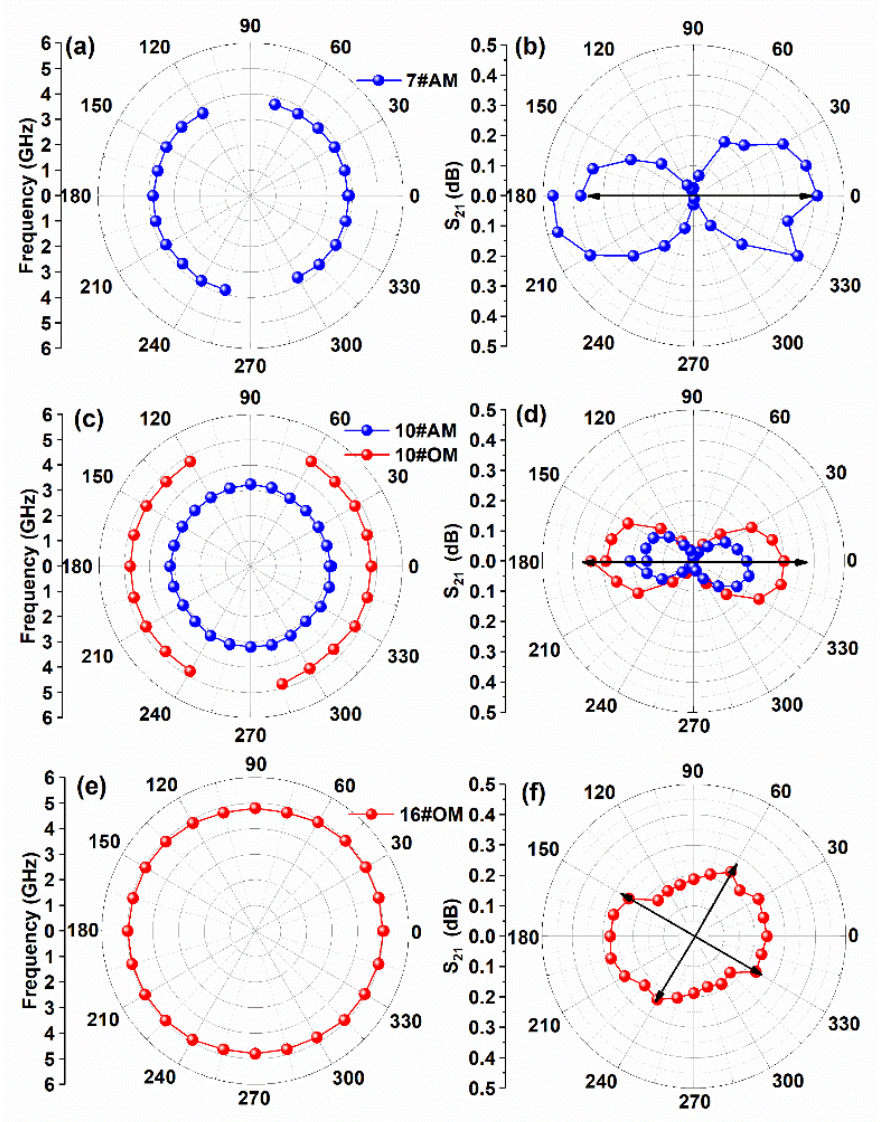
Figure 4. The polar diagrams of FMR frequency (left panels) and S 21 amplitude (right panels) at zero external field for three representative samples with n = 7 ( a , b ), 10 ( c , d ), and 16 ( e , f ), respectively.